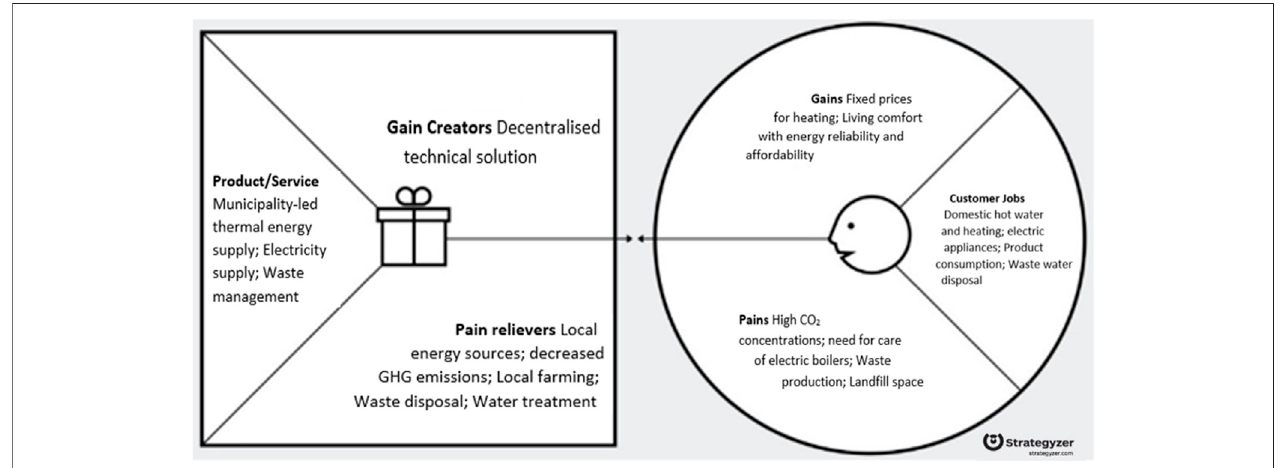
FIGURE 3 | Value proposition canvas (municipal ESCo.) based on Osterwalder et al. (2014), Strategyzer.com, and with copyright by Strategyzer